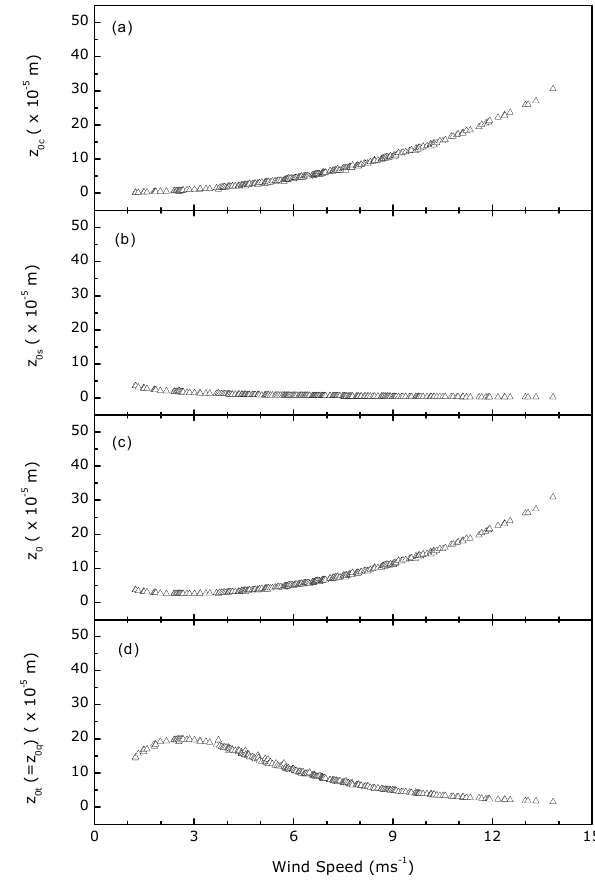
Fig. 7. Wind speed dependence of roughness length: (a) Veloc- ity roughness length - z 0 c ( × 10 − 5 m) (after Charnock, 1955); (b) Velocity roughness length - z 0 s ( × 10 − 5 m) (after Smith, 1988); (c) Velocity roughness length z 0 (sum of z 0 c and z 0 s ), ( × 10 − 5 m); (d) Roughness length for temperature (and humidity) z 0 t (= z 0 q ), ( × 10 − 5